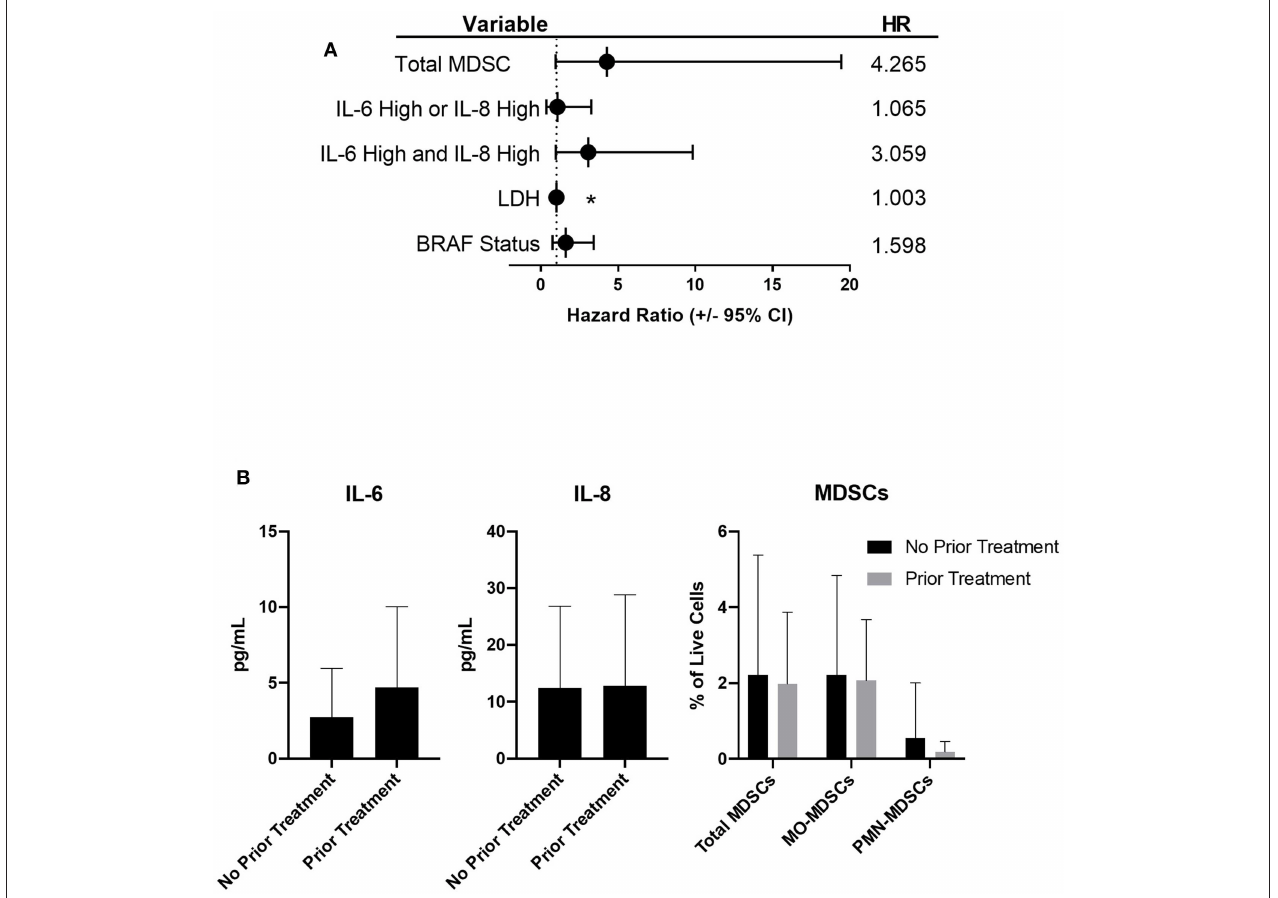
FIGURE 5 | Patients with high frequencies of total MDSCs, or high concentrations of IL-6 and IL-8, have an increased risk of death. (A) Forrest plot depicting the hazard ratios of stage IV patients based on the listed variable, compared to those with low IL-6 and low IL-8 (dotted line). Error bars represent 95% confidence interval. (B) Circulating levels of IL-6, IL-8, and MDSCs in stage IV patients based on prior treatments (no statistically significant differences were observed), * p <